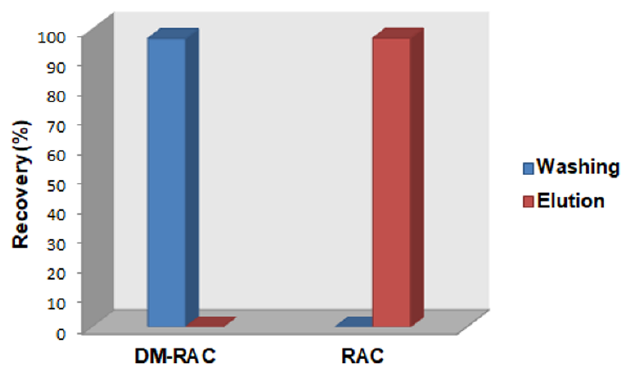
Figure 7. Recovery yield in washing and elution steps for DM-RAC (10 µg mL −1 ) and RAC (10 µg mL −1 ) loaded on RAC-MISPE cartridge packed with RAC-MIP.